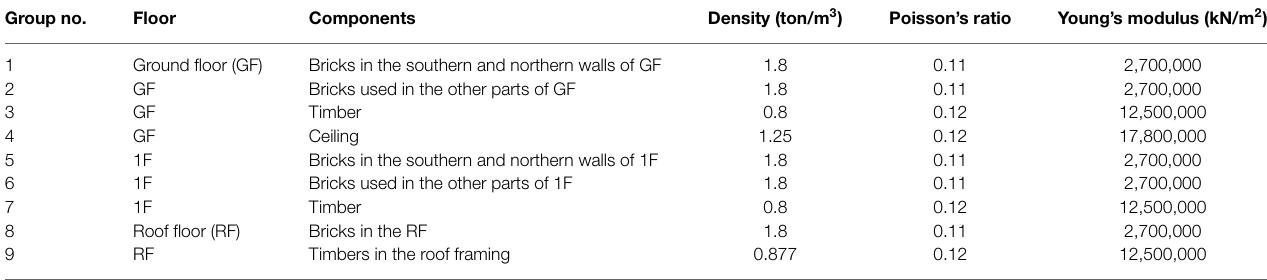
TABLE 3 | Initial finite element model for the building before the earthquake: initial structural parameters of the finite element model for the building before the earthquake. Group no.